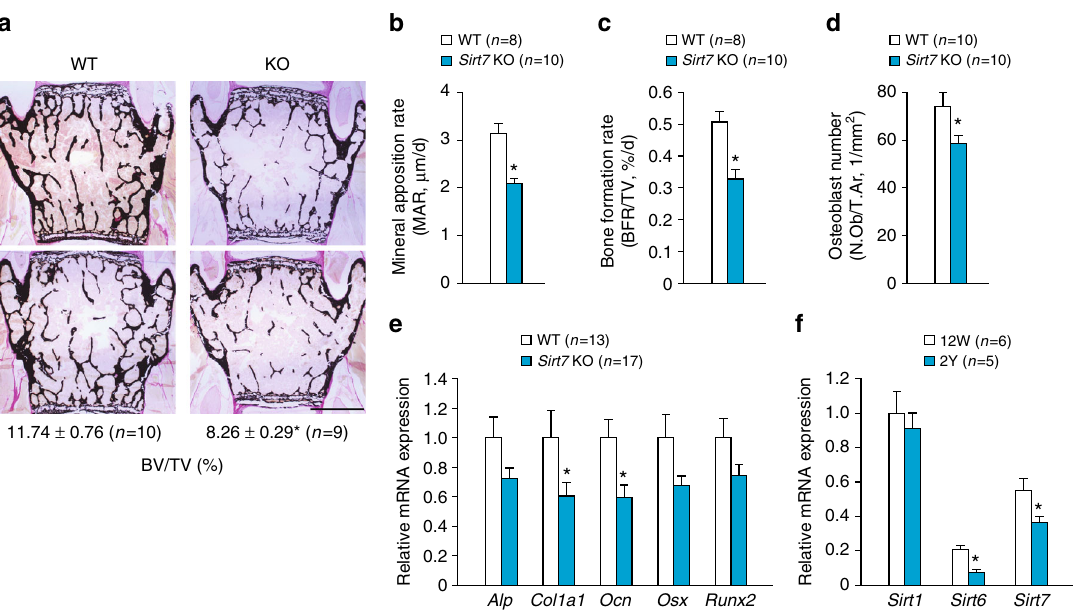
Fig. 2 SIRT7 regulates bone formation. a – d Static and dynamic bone histomorphometric analyses of the lumbar spine (L4) in female Sirt7 KO mice and WT mice aged 14 – 15 weeks. Representative von Kossa-stained images and BV/TV ( a ), MAR ( b ), BFR/TV ( c ), and N.Ob/T.Ar ( d ). e Osteoblastic marker gene expression analyzed by qRT-PCR in femurs harvested from female Sirt7 KO mice and WT mice aged 14 – 15 weeks. f Expressions of Sirtuins analyzed by qRT- PCR in femurs from young (12 weeks old) and aged (2 years old) WT mice. Data are shown as the mean ± SEM. Statistical signi fi cance was determined